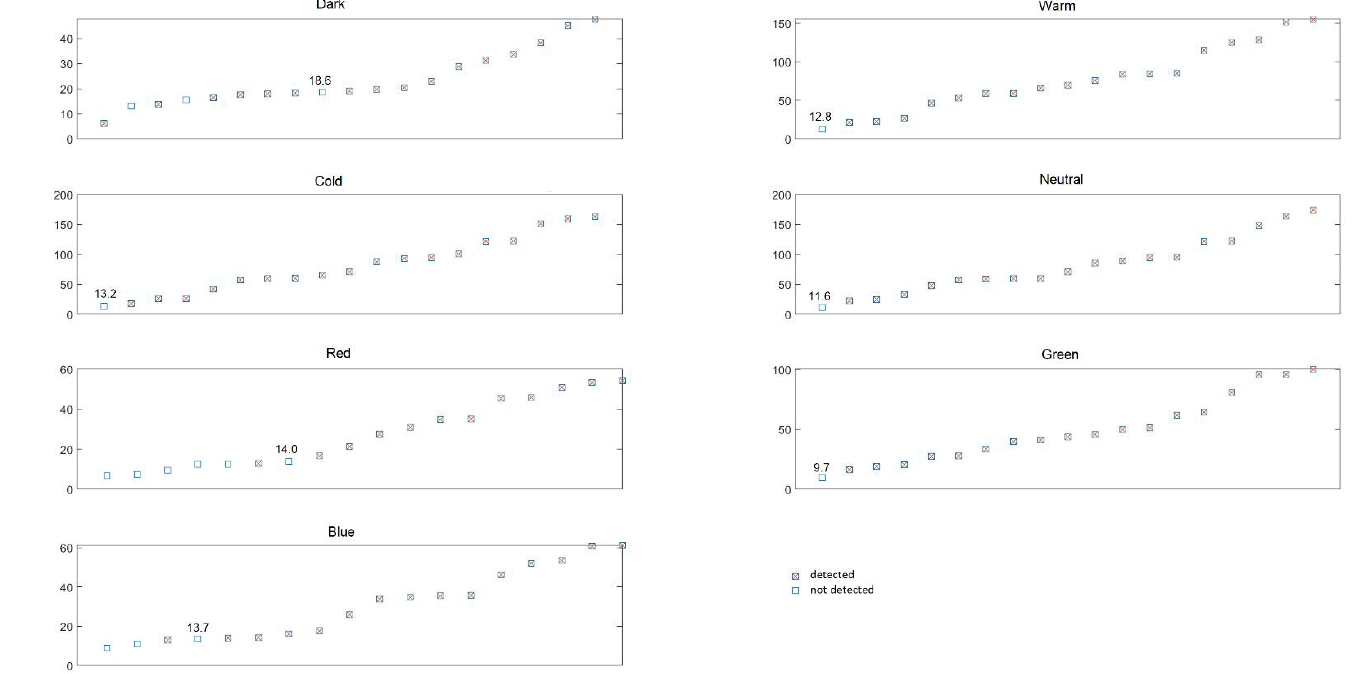
Figure 14. Analysis of the F-points’ detection ability, depending on the MeanL2 feature, divided by study type.